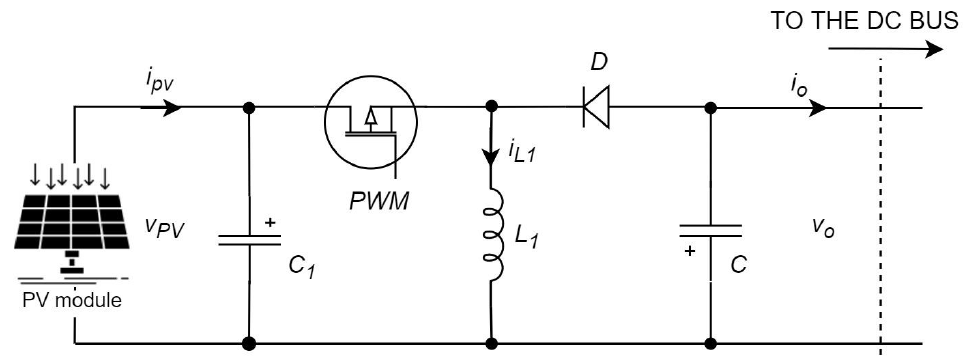
Figure 3. Buck-boost converter connected between PV array and the load.